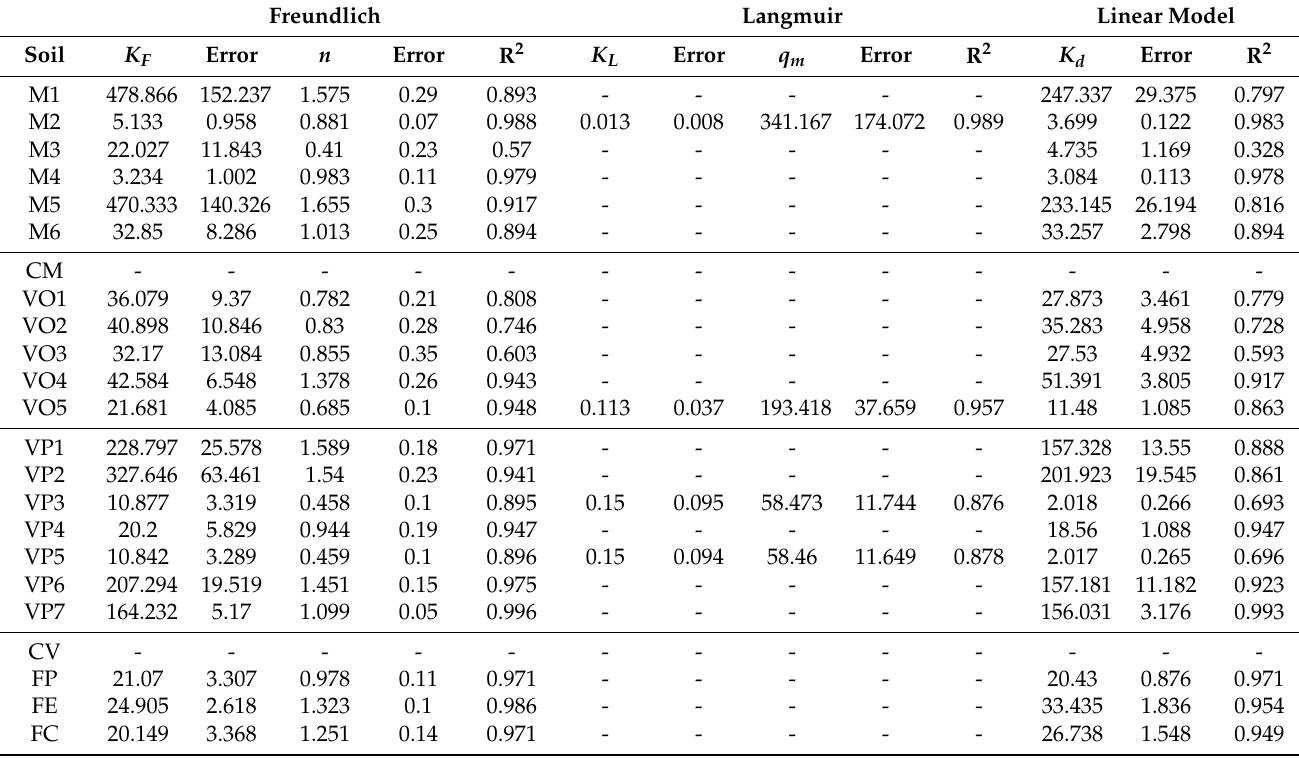
In addition, Table 1 shows the parameters of the adsorption equations obtained from the adjustments of the experimental data to the Freundlich, Langmuir, and Linear mod- els. The adsorption data of most of the soils adjusted better to the Freundlich equation, as indicated by the values of the coefficient of determination obtained for most of the soils (R 2 above 0.9). In the Linear and Langmuir models, R 2 higher than 0.9 was obtained in a smaller number of soils. In addition, this last model was the most affected by high errors (mean squared errors—MSE) associated with the fitting, making it the least ad- equate for the soils in this study. The values of the distribution coefficient ( K d ) of the linear model show wide variation in corn soils (3.08–247.33 L kg − 1 ) and vineyard soils on granite (2.01–201.92 L kg − 1 ), while the range is lower in vineyard soils on schist and slate (11.48–51.39 L kg − 1 ), and especially in forest soils (20.43–33.43 L kg − 1 ). To be noted that, using mean squared errors, only the MSE of different fits to the same data should be compared, as it will depend on the magnitude of the data (larger values tend to have higher variability). Future more detailed treatment of these data could be made using more sophisticated, weighted nonlinear regression, as well as modeling comparison based on likelihood ratio tests and/or Akaike’s Information Criteria (AIC) and Bayesian Information Criteria (BIC). Fitting of adsorption results to the parameters of the Freundlich, Langmuir, and Linear models. K